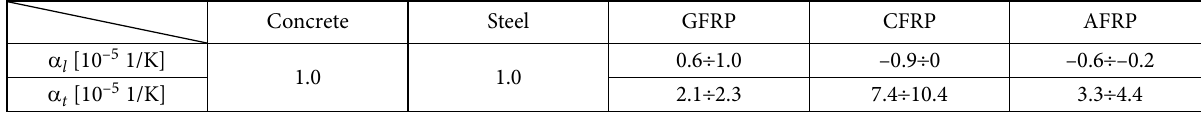
Table 1. Physical properties of materials used in engineering structures